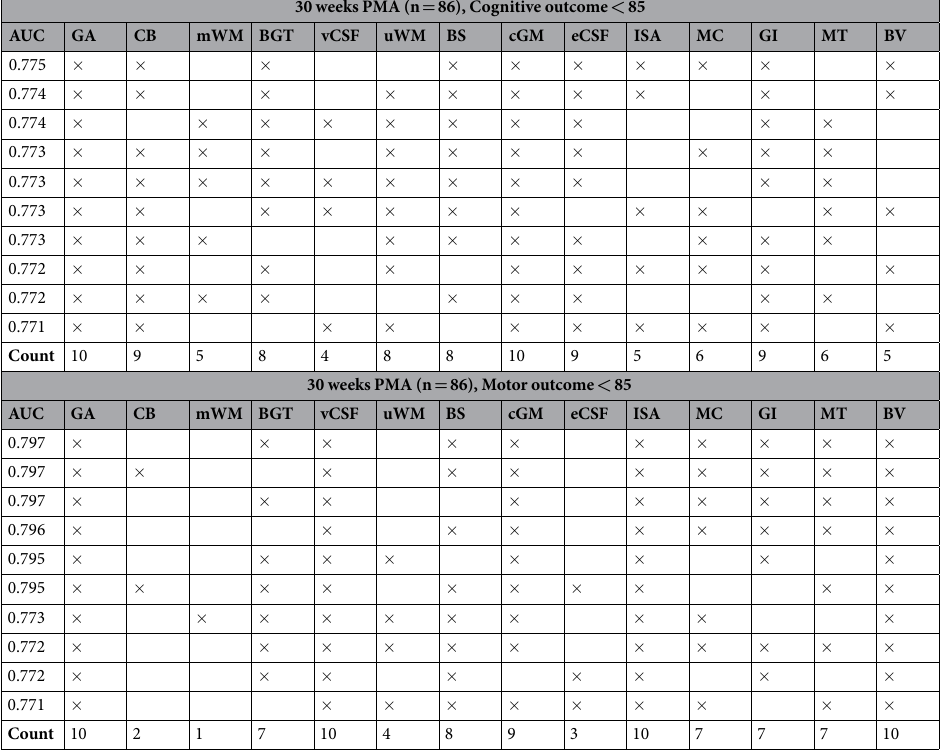
AUC (0.70) was obtained using the combination of GA, BGT volume, vCSF volume, uWM volume, BS volume, cGM volume, eCSF volume, inner cortical surface area, global mean curvature, gyrification index, median cor- tical thickness, and brain volume. Using the predefined sets of descriptors, the highest AUC (0.65) was obtained using all descriptors combined. When the change of the descriptors between 30 and 40 weeks (n = 66) was used, higher AUCs were obtained (Table 4 and Fig. 3, bottom left panel); the highest AUC (0.81) was obtained using the combination of CB volume, mWM volume, BGT volume, vCSF volume, uWM volume, BS volume, eCSF volume, inner cortical surface area, global mean curvature, gyrification index, median cortical thickness, and brain vol- ume. Using the predefined sets of descriptors, the highest AUC (0.79) was obtained using all descriptors (includ- ing GA); the AUCs using only measures of cortical morphology (0.76) and using only volumes (0.74) were lower. For the identification of patients with low motor outcome based on the images acquired at 30 weeks PMA, the highest AUC (0.80) was obtained using the combination of GA, BGT volume, vCSF volume, BS volume, cGM volume, inner cortical surface area, global mean curvature, gyrification index, median cortical thickness, and brain volume (Table 2 and Fig. 3, top right panel). Using the predefined sets of descriptors, the highest AUC (0.79) was obtained when using the combination of all descriptors (including GA). Using only volumes resulted in similar AUCs (0.76 without GA and 0.78 with GA). However, using only measures of cortical morphology resulted in lower AUC (0.65 without GA and 0.66 with GA). Similar to the results for cognitive outcome, the AUC was lower for the descriptors computed from the images acquired at 40 weeks PMA; the highest AUC (0.71) was obtained using the combination of CB volume, mWM volume, vCSF volume, uWM volume, BS volume, eCSF volume, inner cortical surface area, global mean curvature, gyrification index, and median thickness (Table 3 and Fig. 3, middle right panel). Using the predefined sets of descriptors, the highest AUC (0.65) was obtained using volumes only, including the GA decreased the AUC (0.57). When the change between the descriptors of the serial images (n = 66) was used, the highest AUC (0.85) was obtained using the combination of GA, mWM volume, BGT volume, vCSF volume, cGM volume, inner cortical surface area, global mean curvature, gyrification index, median cortical thickness, and brain volume. Using the predefined sets of descriptors, the highest AUC (0.82) was obtained using the combination of all descriptors (including GA) (Fig. 3, bottom right panel); the AUCs using only volumes (0.76) and using only measures of cortical morphology (0.75) were lower.